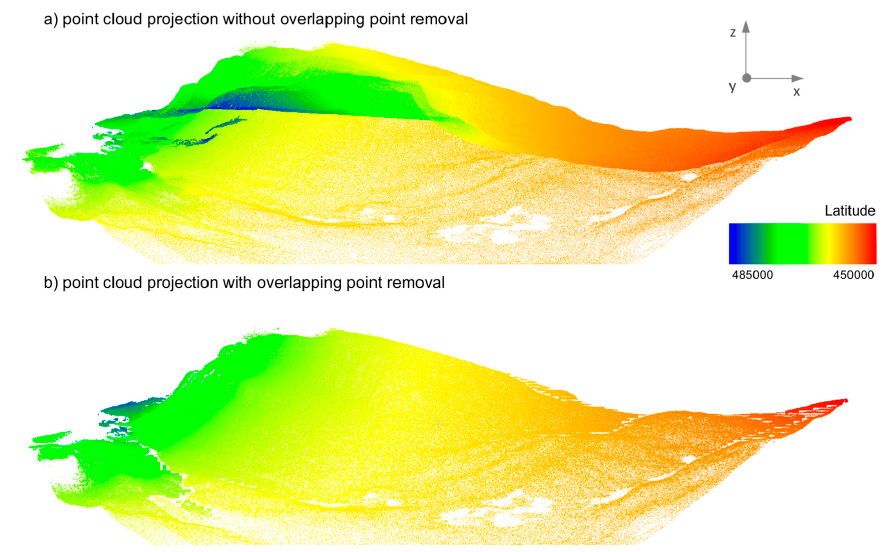
Figure 6. Effect of the overlapping point removal on the quality of the 2D point cloud projection image on the example of Nunngarut, Scan 2. The original x -coordination of the points is illustrated by a colour gradient. ( a ) Point cloud projection without overlapping point removal; ( b ) point cloud projection with overlapping point removal.